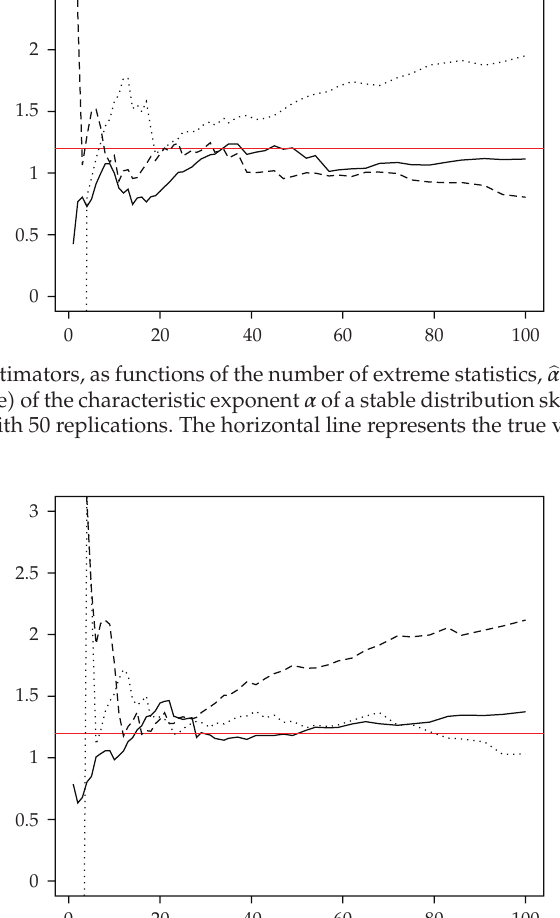
see, for example, Dekkers and de Haan (cid:5) 49 (cid:6) , Drees and Kaufmann (cid:5) 50 (cid:6) , Danielsson et al. (cid:5) 51 (cid:6)